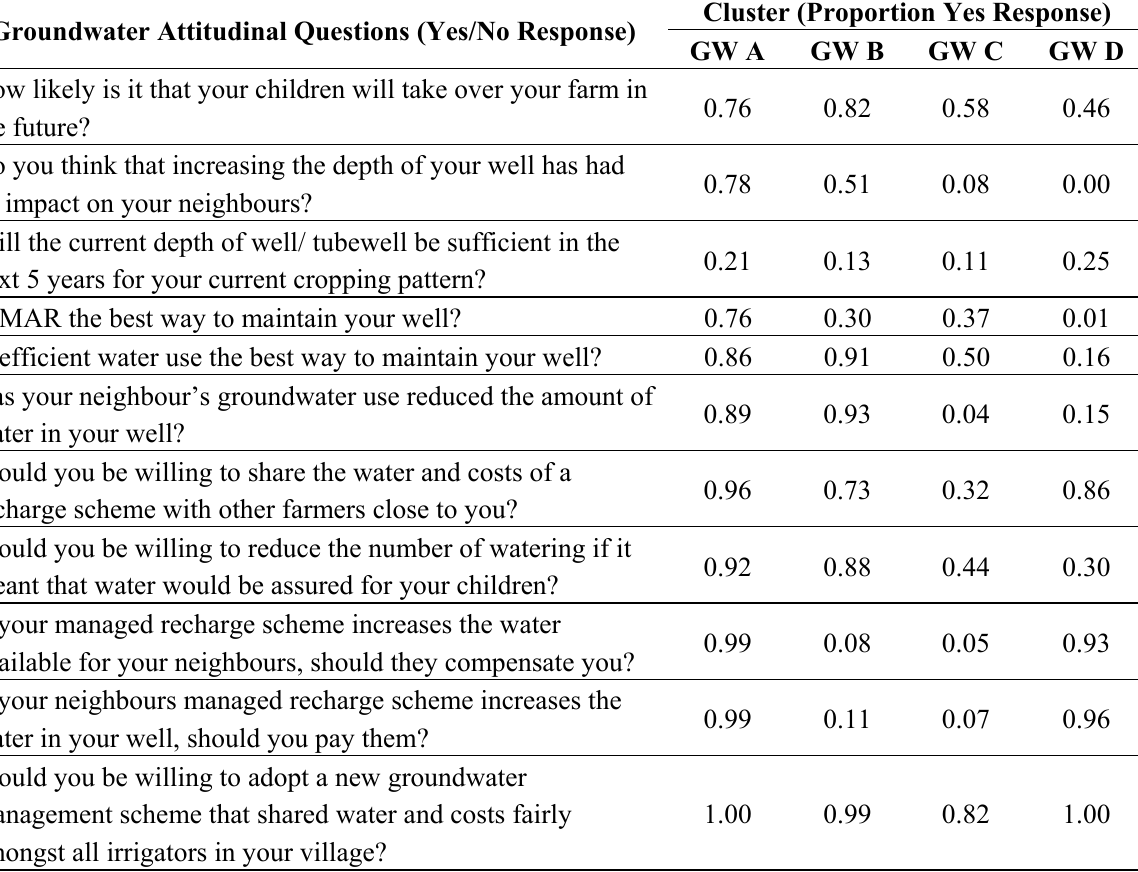
Table 1. Response to different questions for different